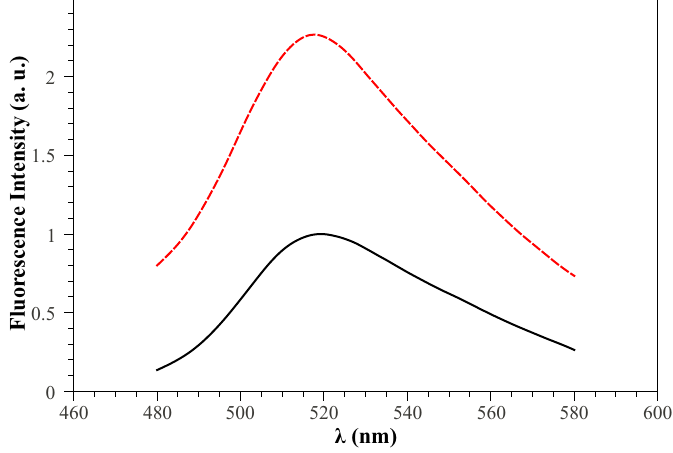
Figure 4. Free GOD fluorescence emission spectrum in the FAD region ( (cid:21) without (black solid curve) and with (red dotted curve) 1 mM glucose concentration.